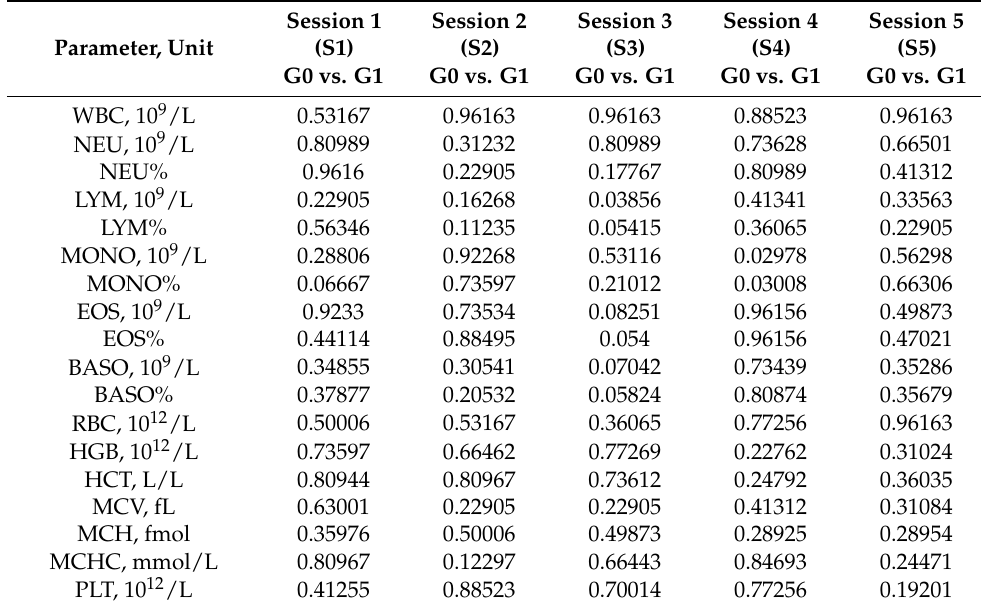
Table 1. p -Value representing differences between supplemented (G1) and control group (G0) for morphological analysis.